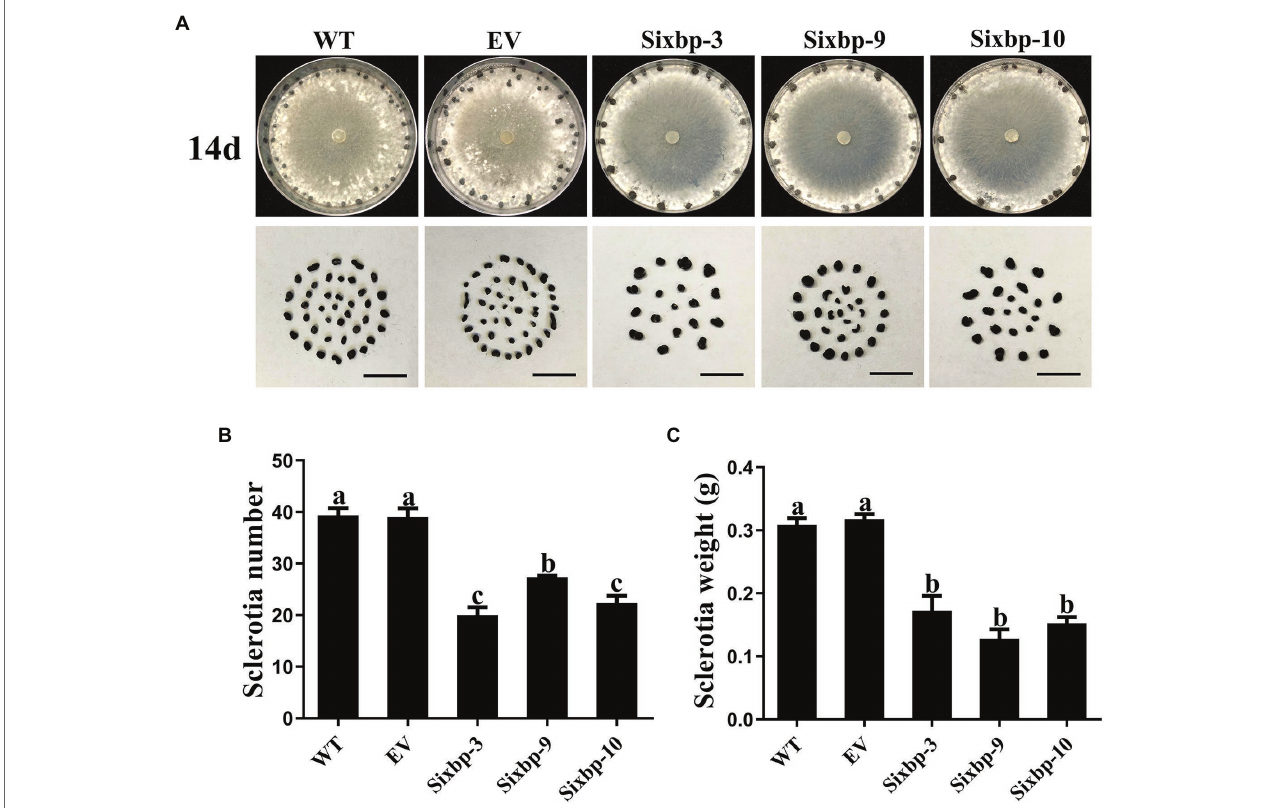
FIGURE 4 | Observations of sclerotia development in WT, EV, and RNAi strains. (A) The sclerotial development of each strain after 14 days on PDA medium. Bar, 5 cm. (B) The number of sclerotia produced by each strain. (C) After 72 h at 37 ° C, the dry weights of the sclerotia of each strain were determined. Different letters above bars represent significant differences ( p < 0.05) as determined using a one-way Duncan’s test. The experiment was repeated three times. Sclerotia development of each strain in different replicates showed similar